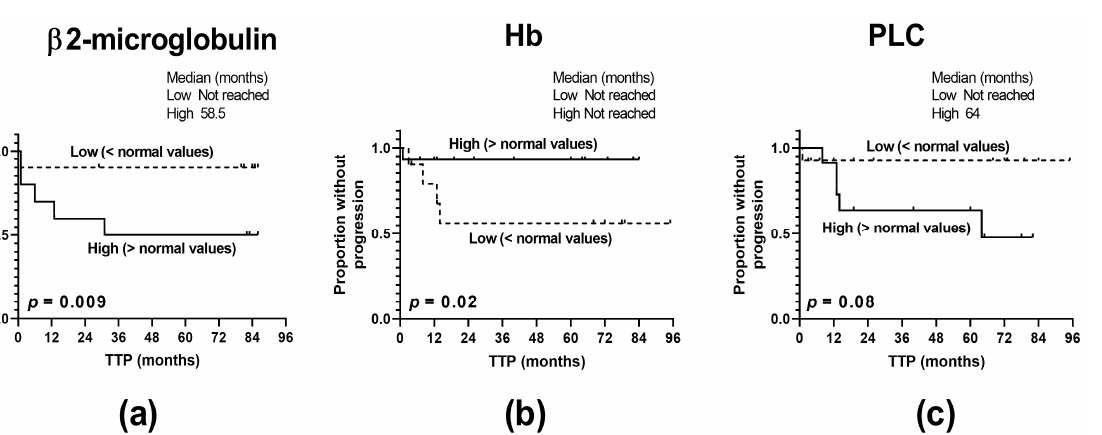
Figure 6. Predictive significance of the clinico-pathological characteristics of MM patients. ( a ) Lev- els of β 2-microblobulin, ( b ) anemia, and ( c ) percentages of circulating plasmacytes (PLCs) affect the time to progression (TTP) of MM patients (n = 40). The log-rank test was performed for the Kaplan–Meier curves.